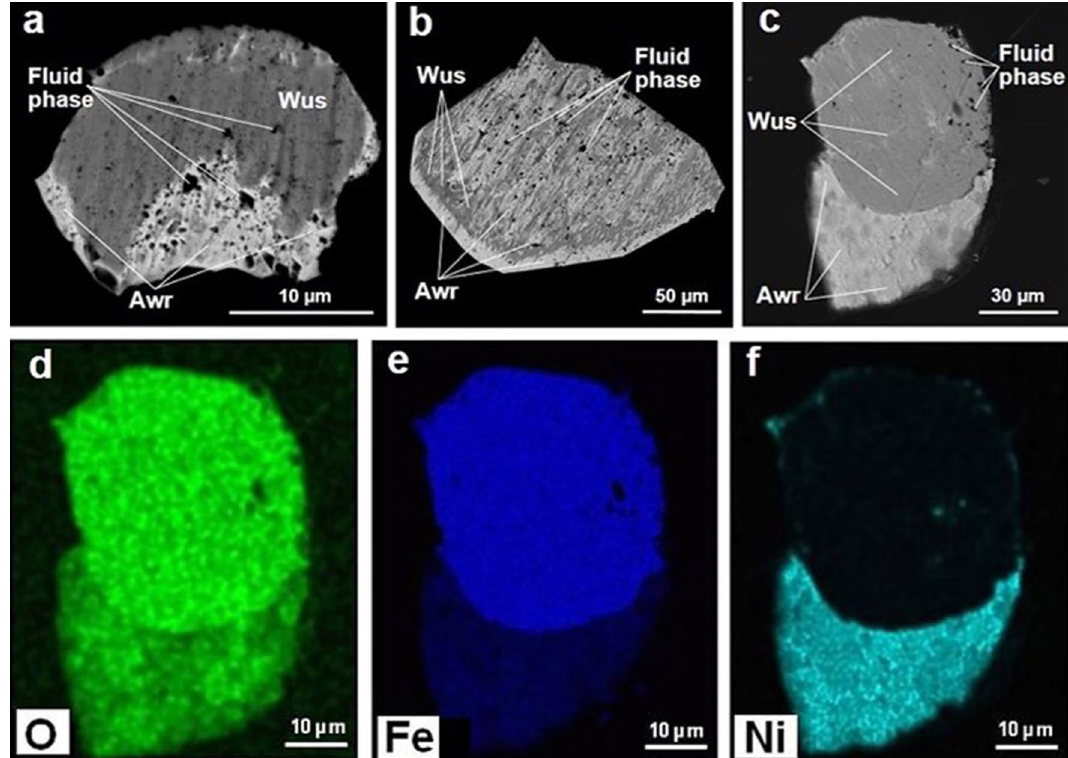
Figure 2. ( a–c ) BSE images of melt inclusions in synthetic diamonds grown in Fe–Ni–C system; ( d–f ) element maps for melt inclusion indicated on ( c ). Wus wustite, Awr